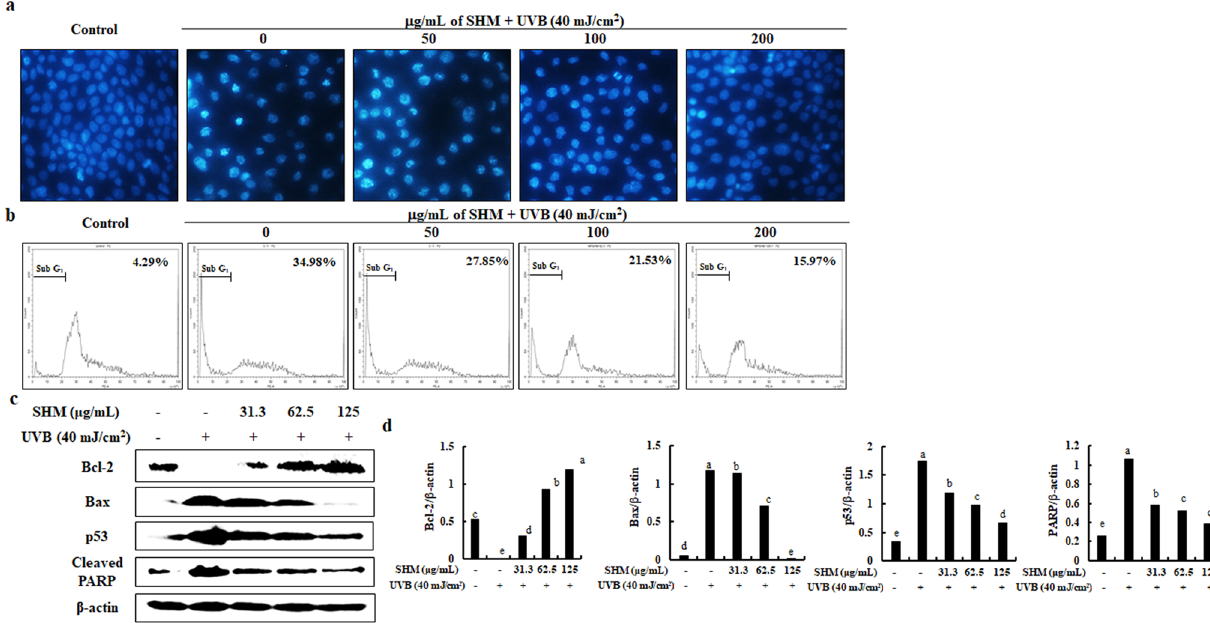
Figure 2. Effect of SHM on apoptosis signaling in UVB-exposed human keratinocytes. ( a ) Apoptotic body formation in SHM-pretreated and UVB-exposed human keratinocytes. The cells were stained with Hoechst 33342 reagent (2 µg/mL) and examined using a fluorescence microscope. ( b ) Analysis of Sub-G 1 apoptotic populations in SHM-pretreated and UVB-exposed human keratinocytes by flow cytometry using propidium iodide (PI). ( c ) The expression levels of mitochondria-mediated apoptotic molecules (Bcl-2, Bax, p53, and PARP) in SHM-pretreated and UVB-exposed human keratinocytes. ( d ) The density ratio of protein expression levels was analyzed via Image J software each in comparison to β-actin. Values are expressed as means ± SE of triplicate determinants (n = 3). a–e Bars with different letters for each molecule represent significant differences (P <